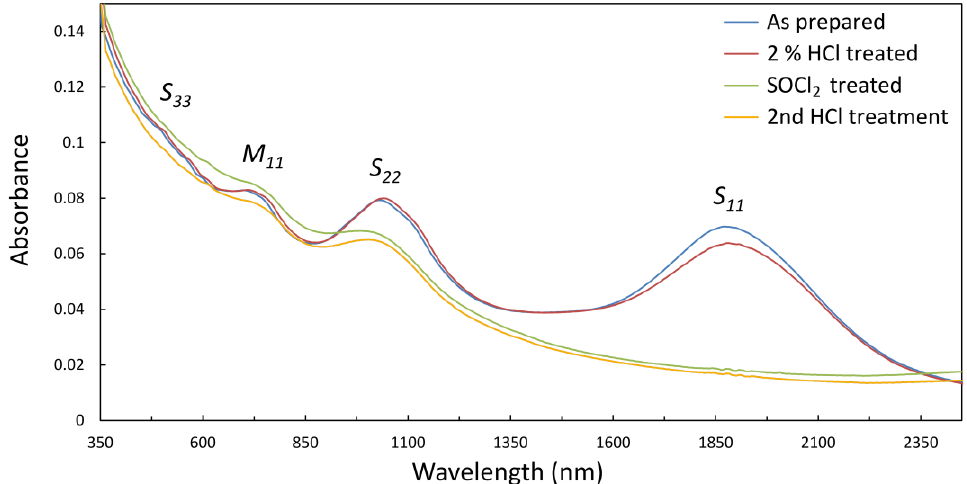
Figure 1. UV-vis-NIR spectra of thin vacuum filtration films of single walled carbon nanotubes (SWCNTs) on glass, made from aqueous TritonX-100 suspensions of large diameter arc-discharge